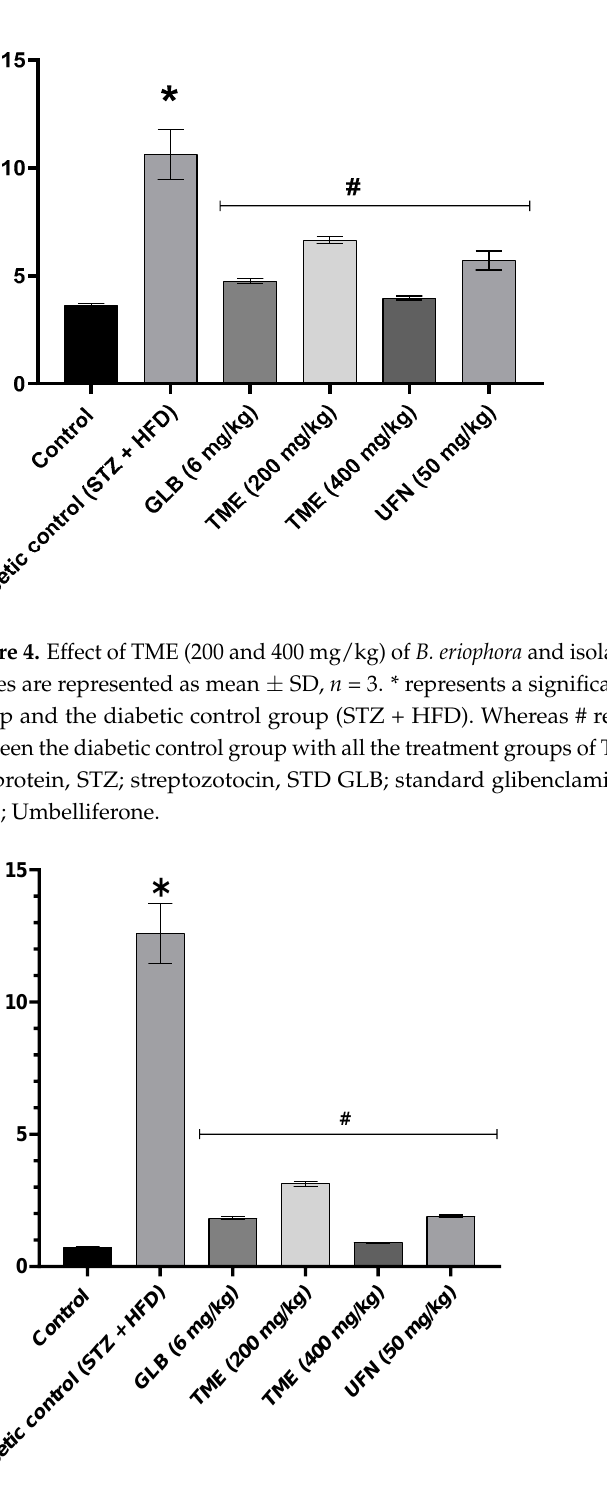
Figure 5. Effect of TME of B. eriophora and isolated UFN on insulin resistance (HOMA-IR index). Values are represented as mean ± SD, n = 3. * represents a significant difference between the control group and the diabetic control group (STZ + HFD). Whereas # represents a significant difference between the diabetic control group with all the treatment groups of TME and UFN. HDL; high-density lipoprotein, STZ; streptozotocin, STD GLB; standard glibenclamide, TME; total methanol extract, UFN; Umbelliferone HOMA-IR; Homeostatic Model Assessment-Insulin Resistance.